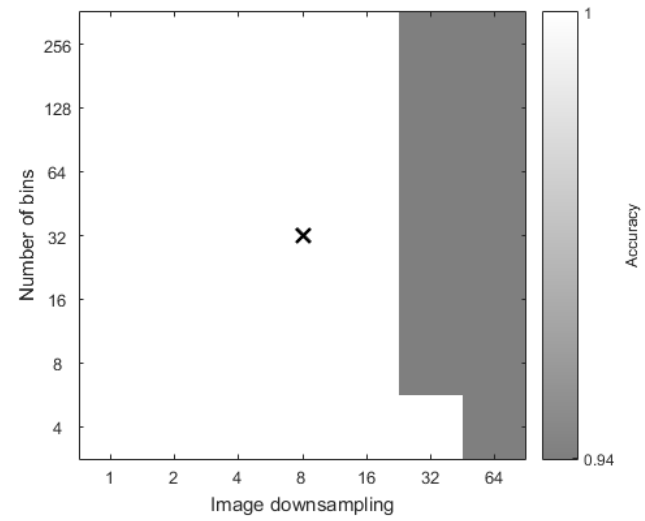
Figure 7. Accuracy as a function of the number of bins in the histogram and the downsampling of the image based on the image training set. The bold × indicates the selected optimal